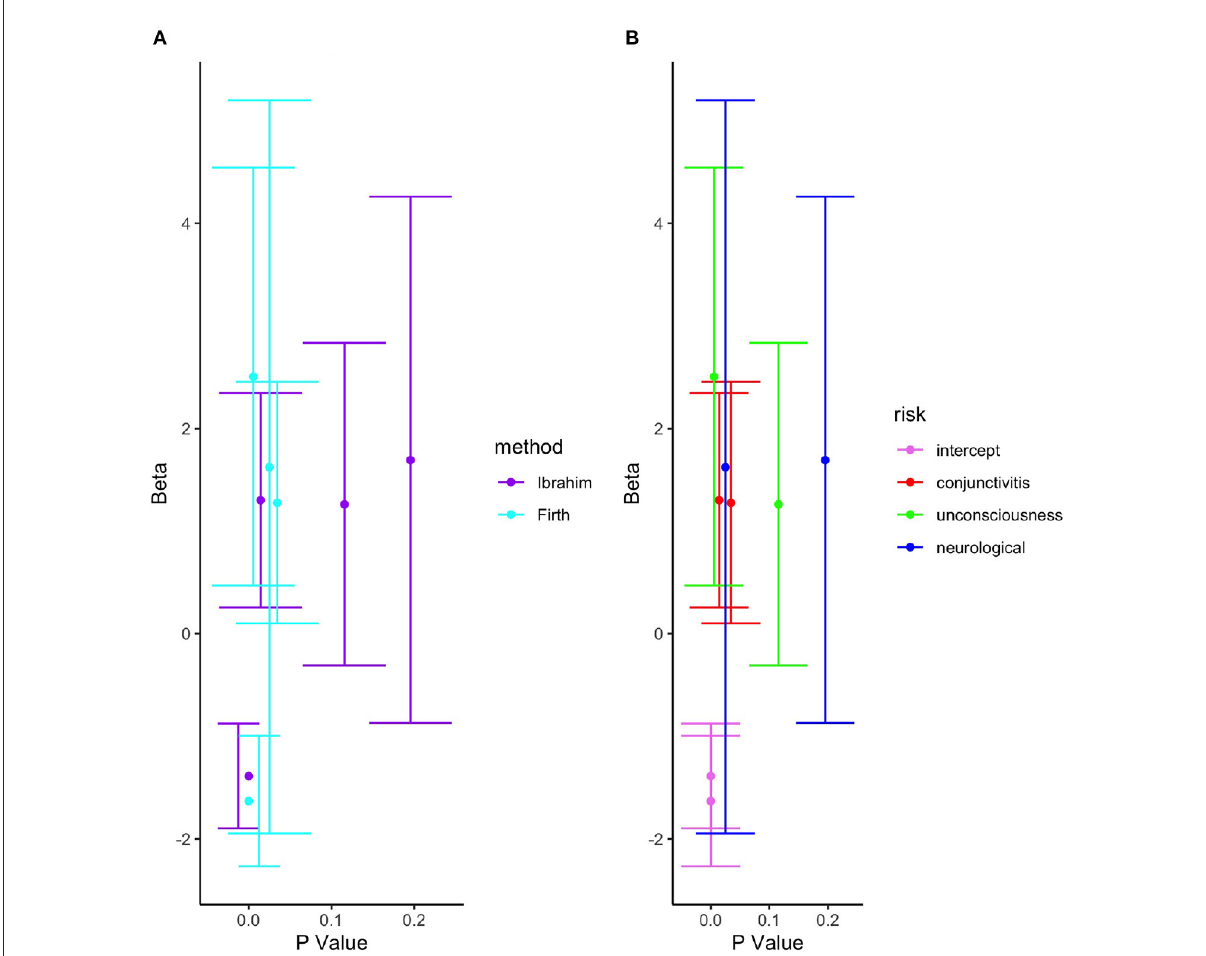
FIGURE1 Bias reduction under the Ibrahim and firth methods. (A) Beta vs. P by method. (B) Beta vs. P by risk.